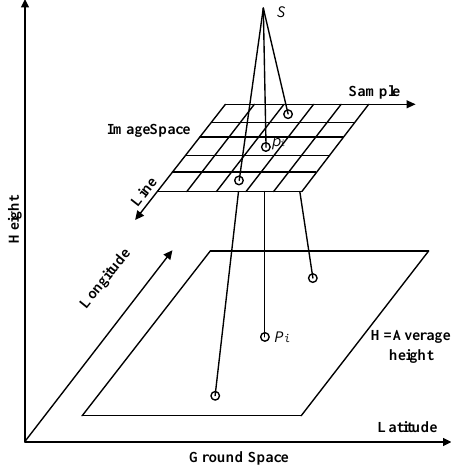
Figure 3. Generation of virtual control points for linear satellite image